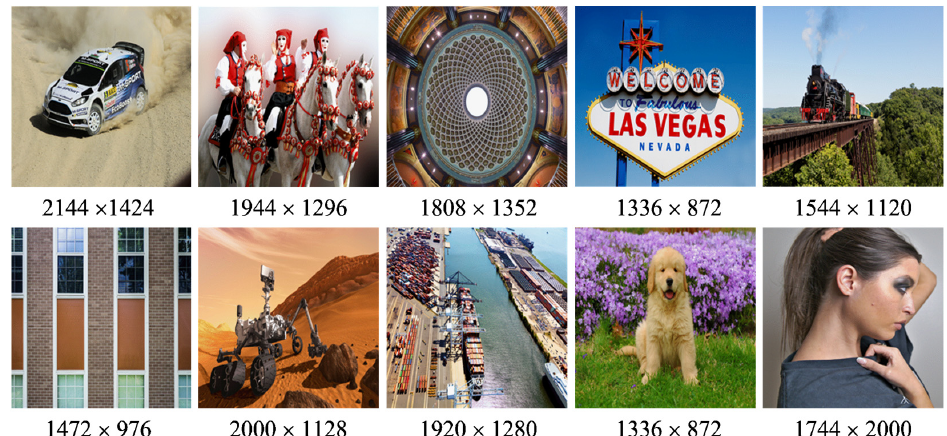
Figure 3. The thumbnails and resolutions of selected raw images from the JPEG-AI test dataset for the subjective test.